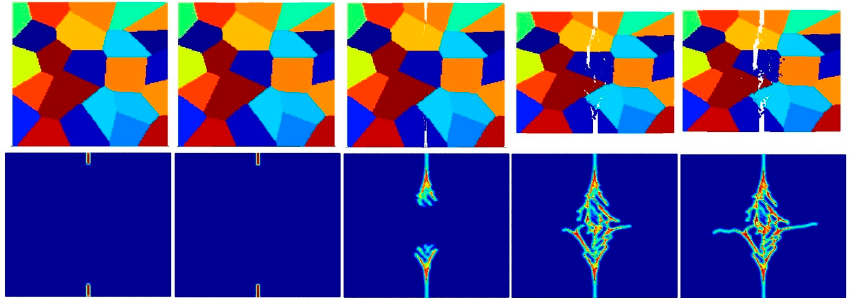
Figure 26. Fracture pattern of polycrystal when β = 1.0 with 25 grains in total. From left to right: time = 1.5 µ s, 2.0 µ s, 2.5 µ s, 3.0 µ s, and 3.5 µ s, respectively.